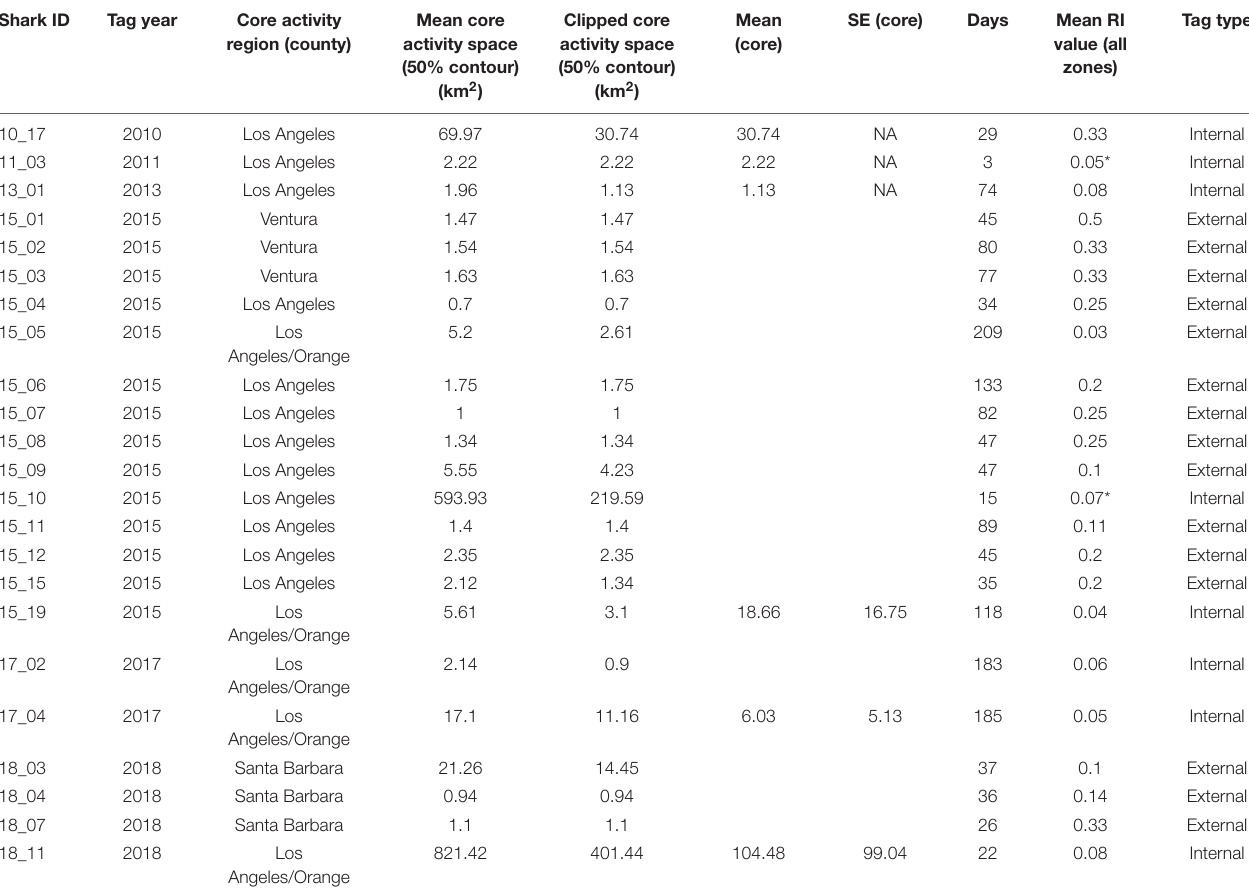
TABLE 2 | Individual core activity space estimates derived from Brownian Bridge Kernel Utilization Densities and clipped (adjusted for terrestrial overlap) estimates. Shark ID Tag